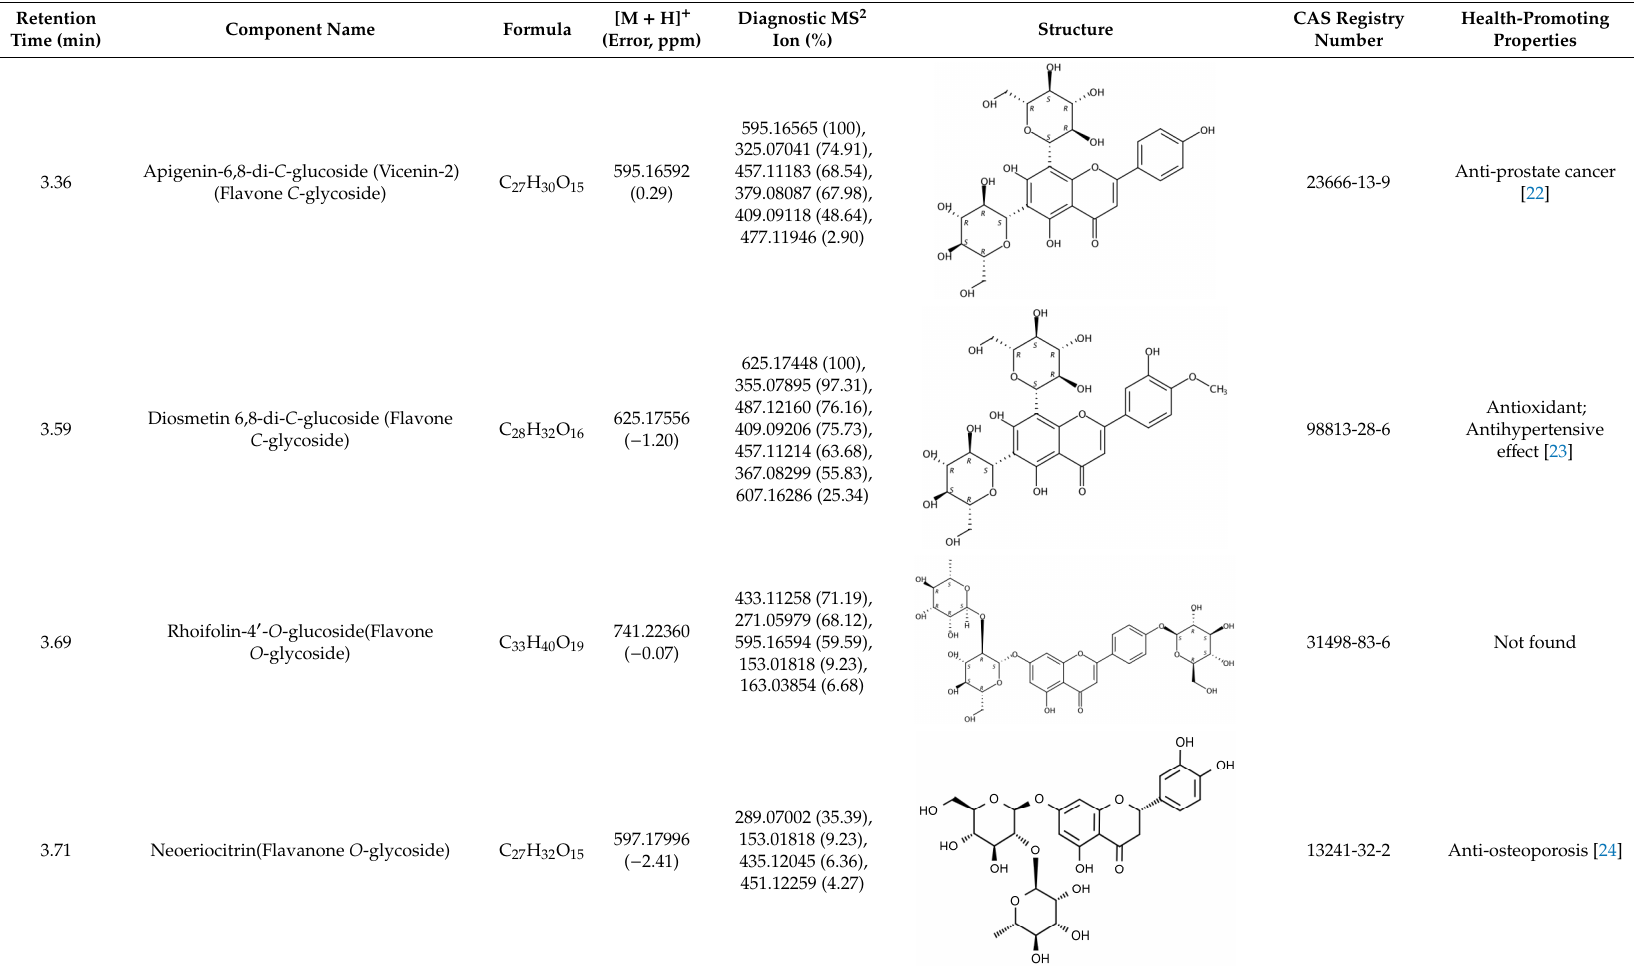
Table 1. Summary of the 21 compounds